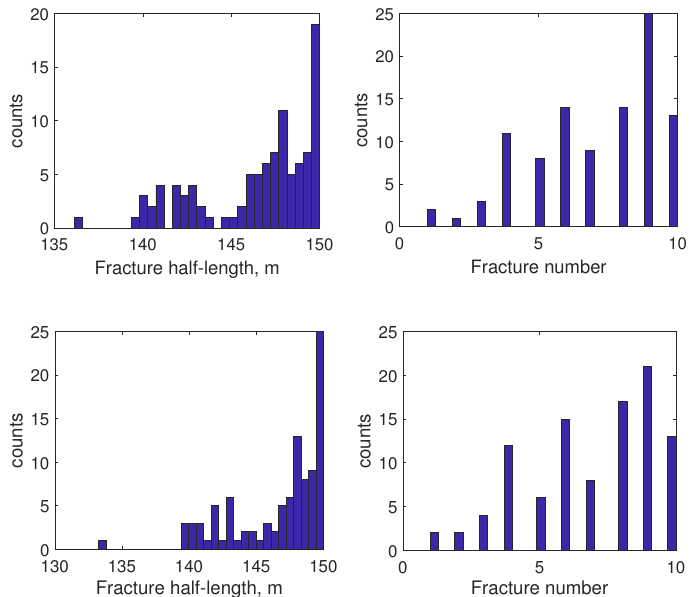
Figure 16. Distributions of optimized hydraulic fracturing parameters with respect to the number of population sizes. The subfigures from top to the down position are corresponding to 50, 100, 150, 200 and 250 population size.